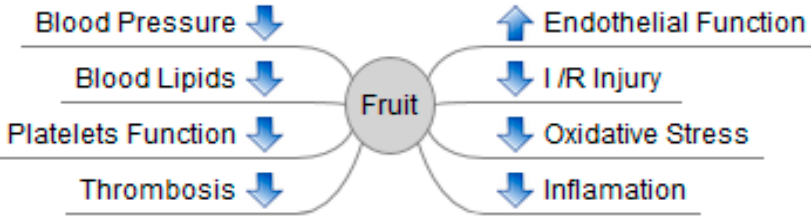
Figure 1. Effects and mechanisms of fruits on cardiovascular diseases (CVDs).